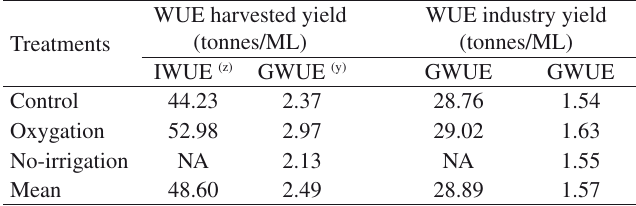
Table 11 - Water use efficiency (irrigation water use efficiency and to- tal water use efficiency) of the harvested sample yield and industry yield in different irrigation treatments for the total yield averaged over the main and ratoon crop WUE harvested yield WUE industry yield (tonnes/ML) Treatments